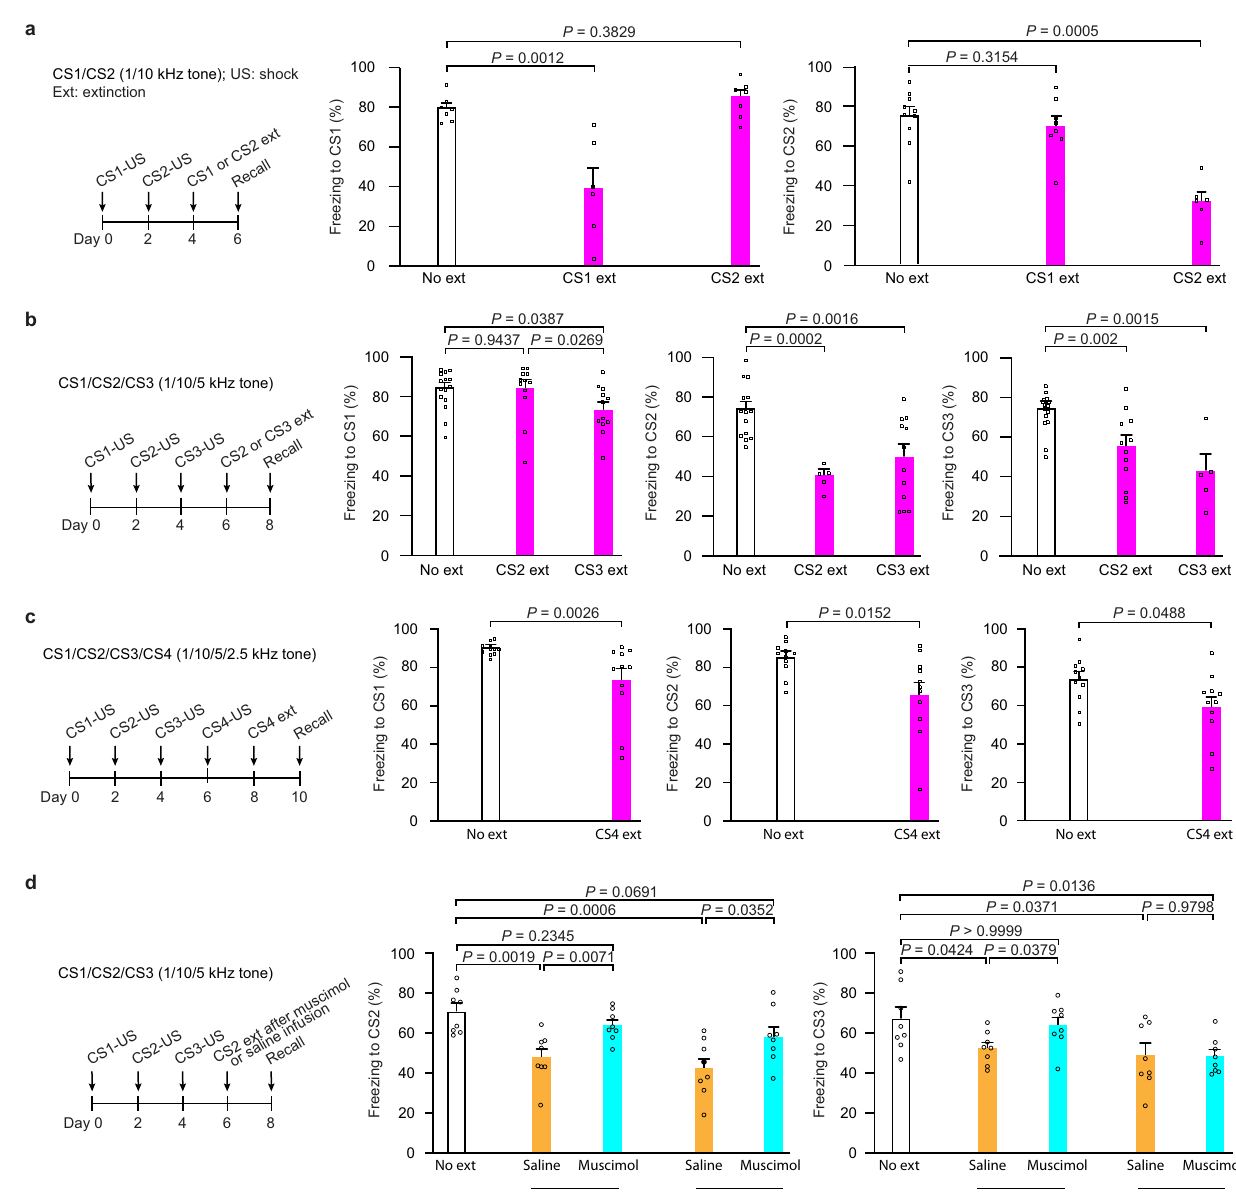
Fig.1|Themotorcortexisimportantforfearextinctiongeneralization.a Mice (YFP-H line) were subjected to CS1-US and CS2-US pairings followed by CS1 or